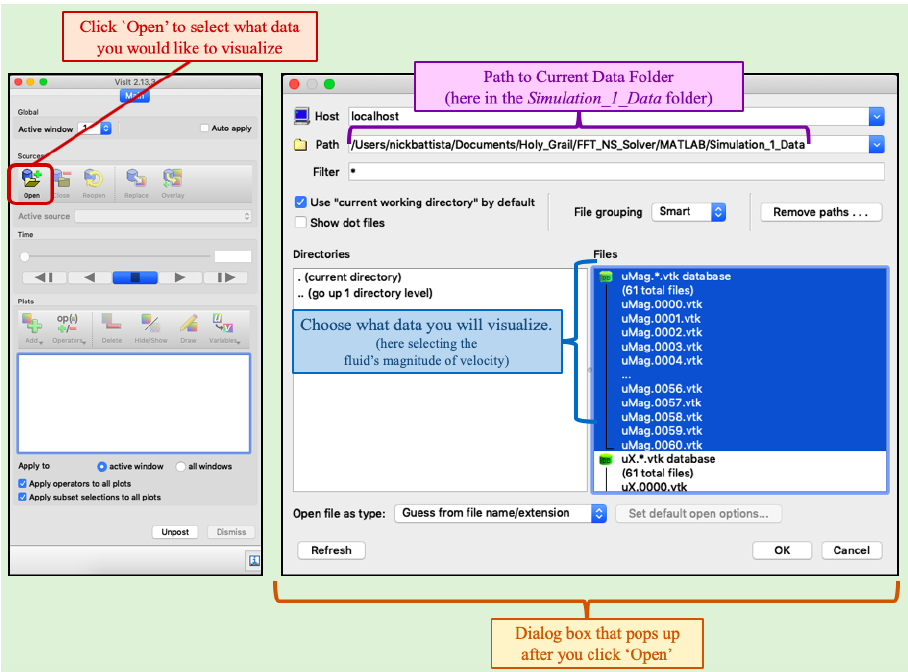
Figure 9. Opening specific simulation data to visualize in VisIt.